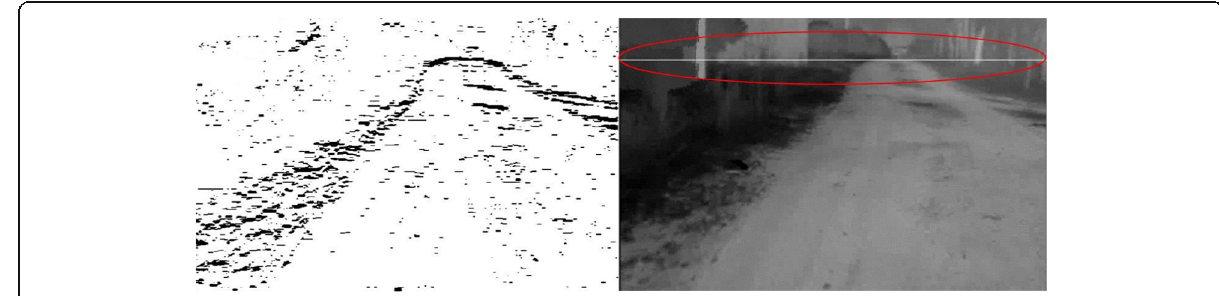
Fig. 18 Vanishing line detection. a Vertical gradient map based on Sobel operator. b Vanishing line detection result